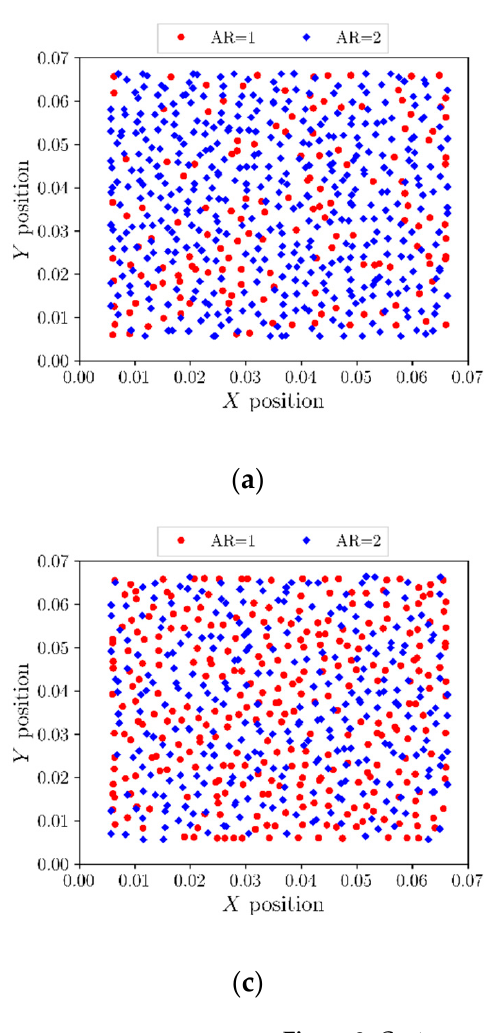
( f ) Figure 3. Projected positions of particles in horizontal plane for binary mixtures of ( a ) AR = 1 (25%) and AR = 2 (75%), ( b ) AR = 1 (25%) and AR = 3 (75%), ( c ) AR = 1 (50%) and AR = 2 (50%), ( d ) AR = 1 (50%) and AR = 3 (50%), ( e ) AR = 1 (75%) and AR = 2 (25%) and ( f ) AR = 1 (75%) and AR = 3 (25%).